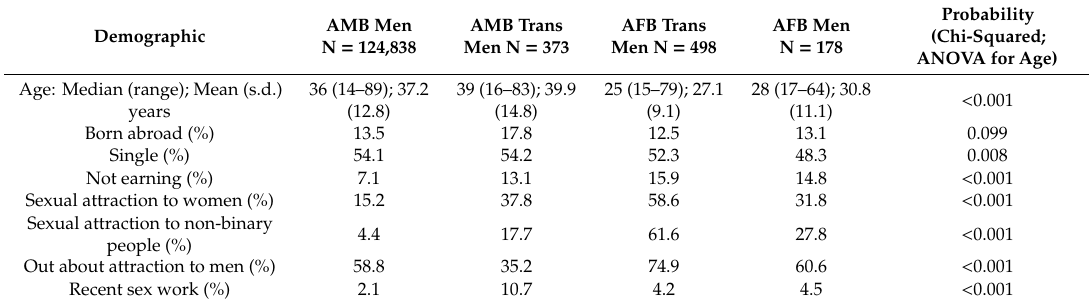
Table 1. Description of four sex-assigned-at-birth / current-gender-identity subgroups of men who have sex with men (MSM), European MSM Internet Survey